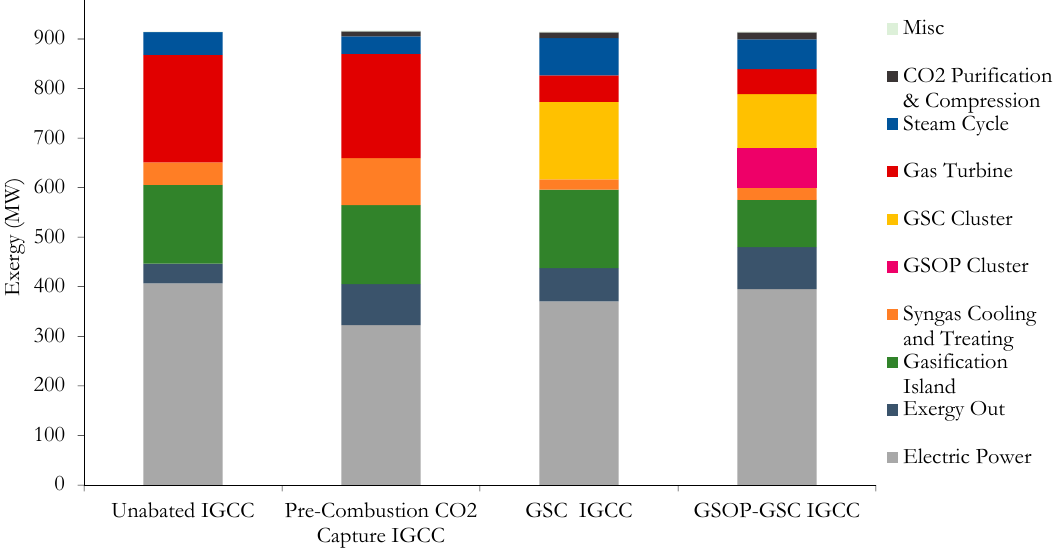
Figure 7. Total exergy breakdown of the different power plants.